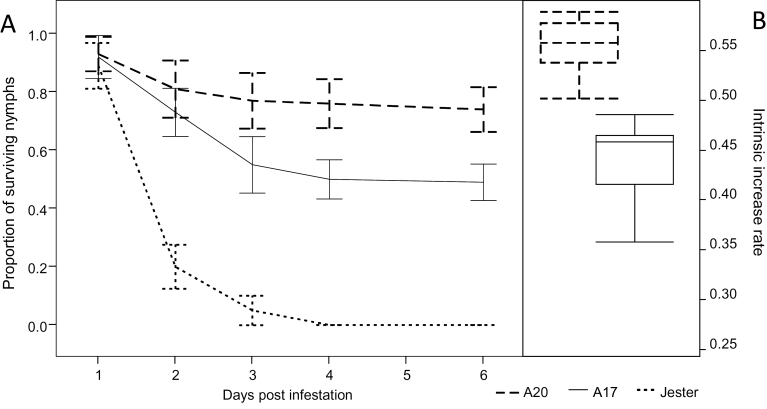
Effect of M. truncatula accessions on nymph survival and intrinsic rate of increase. (A) The proportion of survival on A20, A17, and Jester was monitored from first-instar nymph to adult stage in a non-choice experiment; each plant was infested with five cohort nymphs. Error bars are 95% confidence intervals of the mean (n=10). (B) The intrinsic rate of increase (r
m) of aphids was calculated based on pre-reproductive time in days and number of offspring produced on single caged leaves per plant of A17 and A20 (n=10); no aphid reproduction was observed on Jester. Data are represented by outlier box plots.